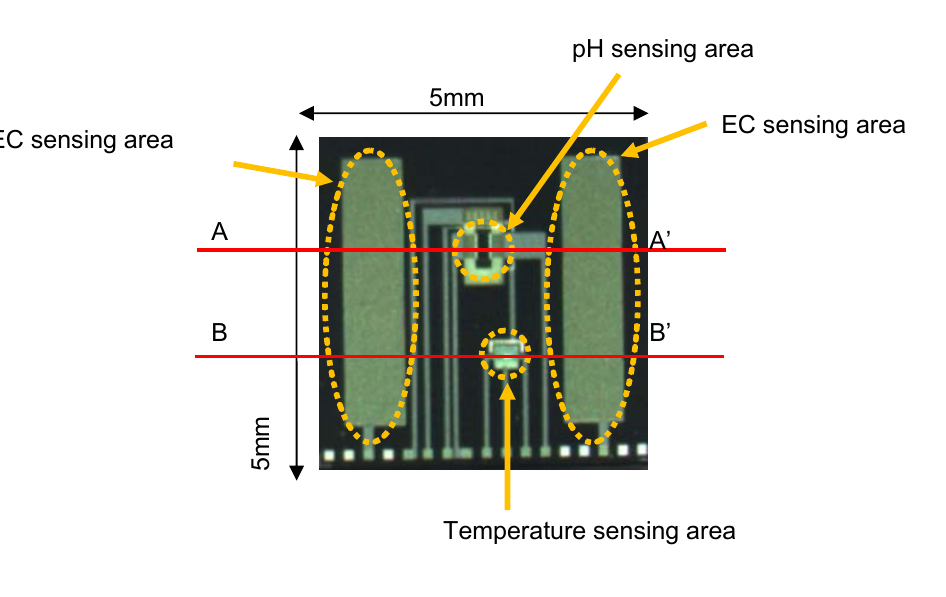
Figure 3. Photograph of an integrated multimodal sensor chip with pH, EC, and temperature sensing